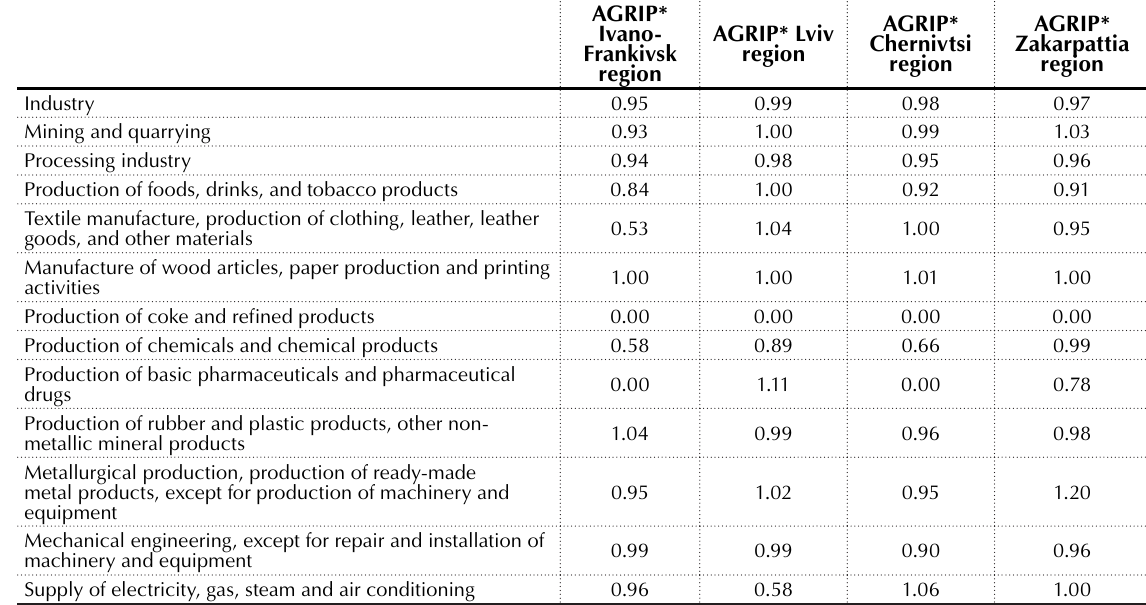
Table 1. Growth areas of the Carpathian economic region are identified as having the highest industrial growth rates in